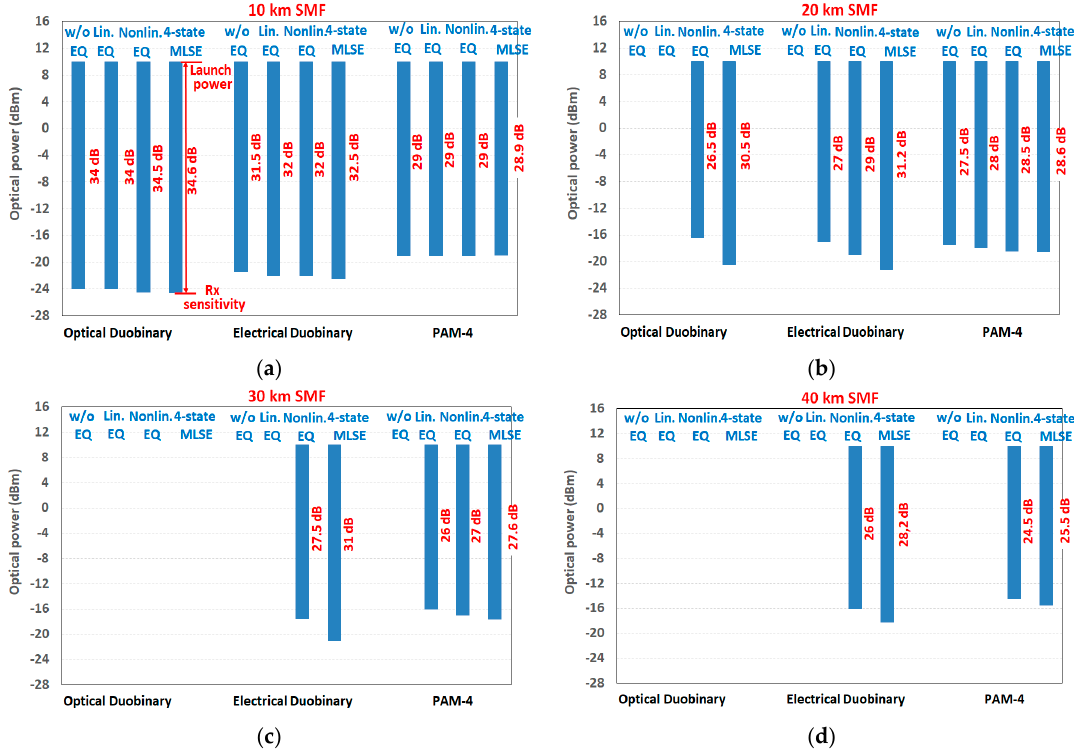
Figure 5. Link power budget for each modulation format under various DSP configurations for transmission distances of ( a ) 10 km, ( b ) 20 km, ( c ) 30 km, and ( d ) 40 km. The optical power sensitivity shown in Figure 4 is considered to calculate the link power budget.